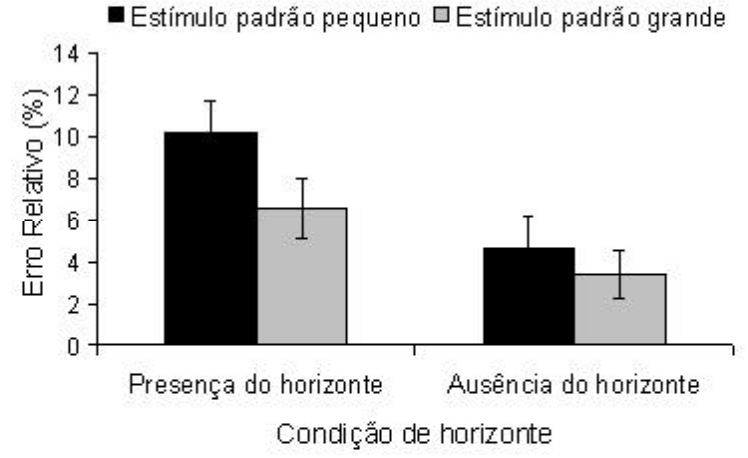
Figura 3. Efeito do horizonte sobre os julgamentos de tamanho relativo. Nota . * ( p< 0,001) presença do horizonte comparado com ausência do